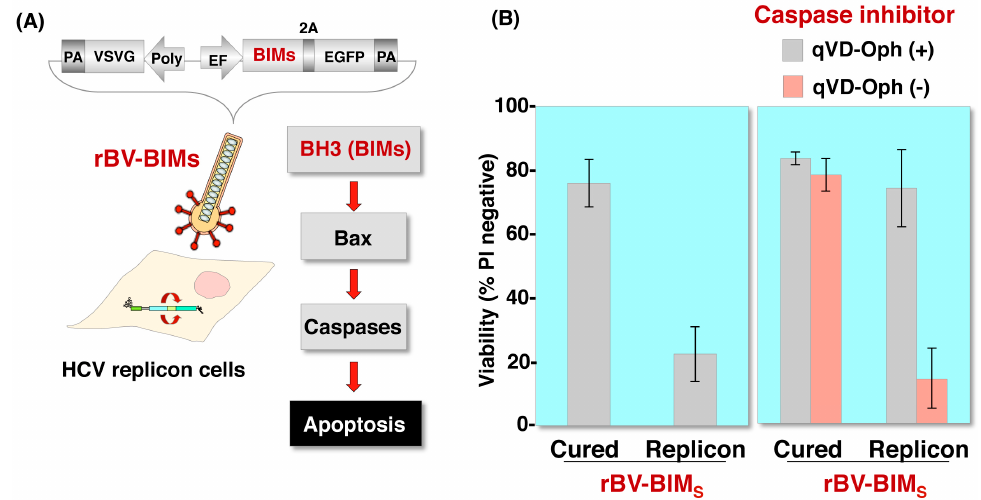
Figure 4. Induction of apoptosis in cells replicating HCV RNA by a recombinant baculovirus expressing a proapoptotic protein. ( A ) Structure of a recombinant baculovirus, rBV-BIM S , carrying cDNAs of BIMs 2A peptides, and enhanced green fluorescent protein (EGFP) under the control of the elongation factor 1 α [71] promoter. The apoptosis pathway was induced by BIMs. ( B ) HCV replicon cells (HCV-RNA-replicating Huh7 cells) and cured cells (replicon cells from which HCV-RNA was eliminated) were infected with rBV-BIM S at an MOI of 500, and cell viability was determined at 24 h post infection. rBV-BIM S can induce apoptosis more efficiently against HCV replicon cells than cured cells (left). HCV replicon cells and cured cells were infected with rBV-BIM S at an MOI of 500 in the presence or absence of 20 μ M qVD-Oph (caspase inhibitor), and cell viability was determined at 24 h post infection. The results show that infection with rBV-BIM S selectively induced apoptosis in HCV replicon cells through the activation of Bcl-2 family proteins (right).